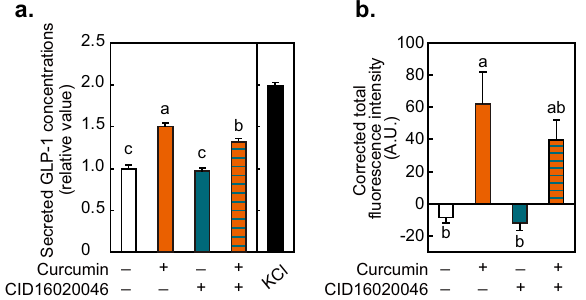
Fig. 7 Effects of curcumin and GPR55 antagonist on GLP-1 secretion and intracellular Ca 2 + levels in GLUTag cells. a GLUTag cells that had been pretreteated with CID16020046 or vehicle for 30 min were stimulated with curcumin for 1 h. KCl (50 mM) was used as positive control. Secreted GLP-1 levels in the supernatant were determined by ELISA. b Fura-8 fl uorescence intensity was deter- mined in the presence or absence of curcumin and CID16020046. Data are expressed as the means ± s.d. ( n = 4). Different letters indicate signi fi cant differences ( p < 0.05). A.U., arbitrary